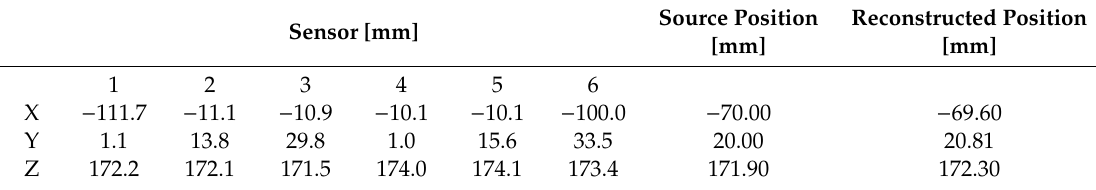
Table 1. Estimated position of the Bragg peak energy deposition. Sensor [mm]